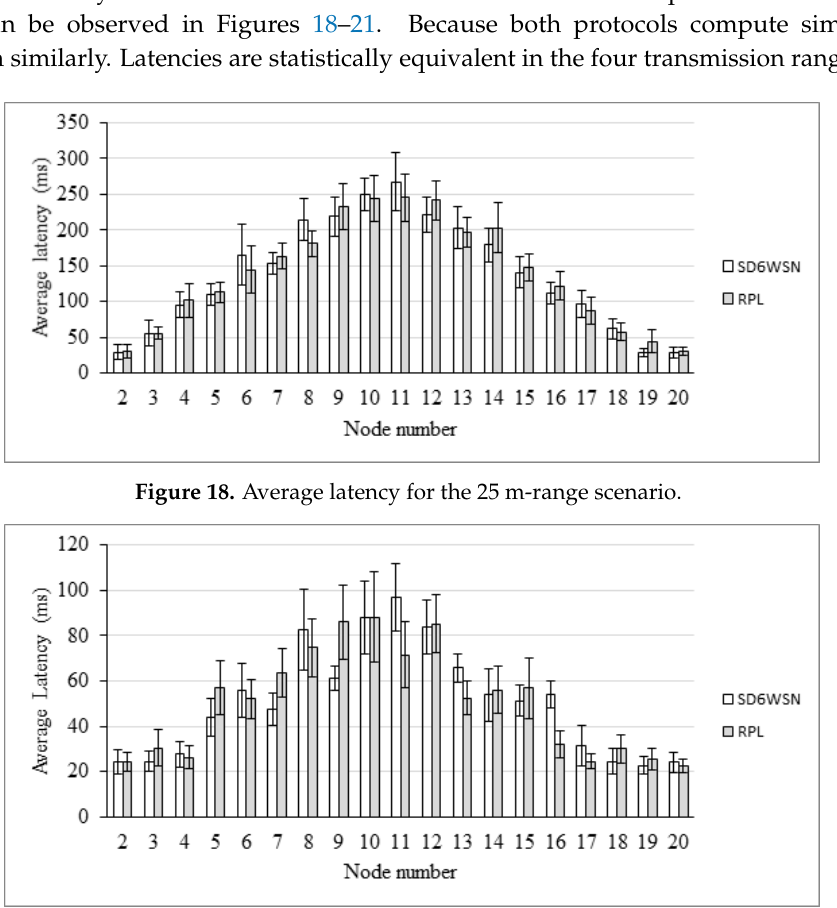
Figure 19. Average latency for the 50 m-range